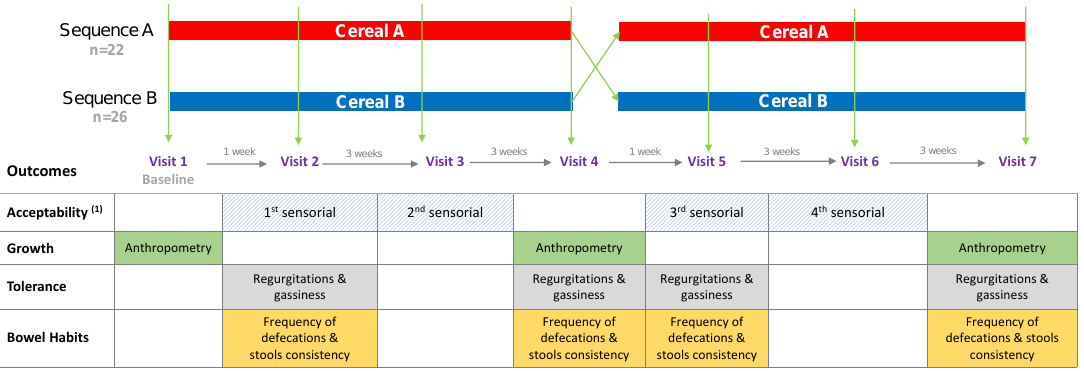
Figure 1. Diagram of the study protocol: Intervention, time-points and measured variables. Cereal A—0% whole grain and 24 g / 100 g and Cereal B—50% whole grain and 12 g / 100 g